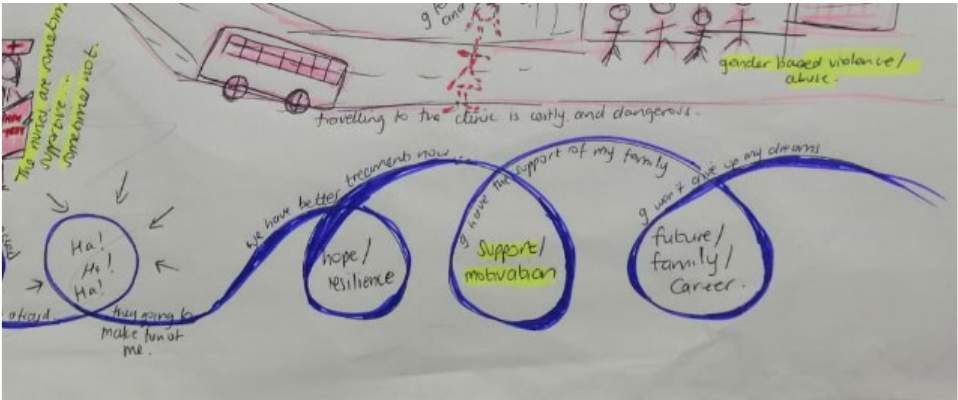
Figure 15: Motivation to be healthy and adhere